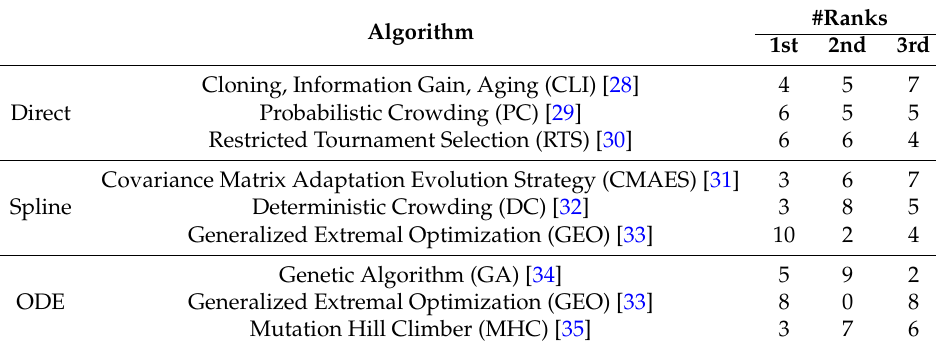
Table 2. Overview of the top three optimization algorithms for each fingerprint-generating function, selected based on Supplementary Figures S1–S3. We ranked the results of the algorithms for each dataset based on the log likelihood ratios and counted the